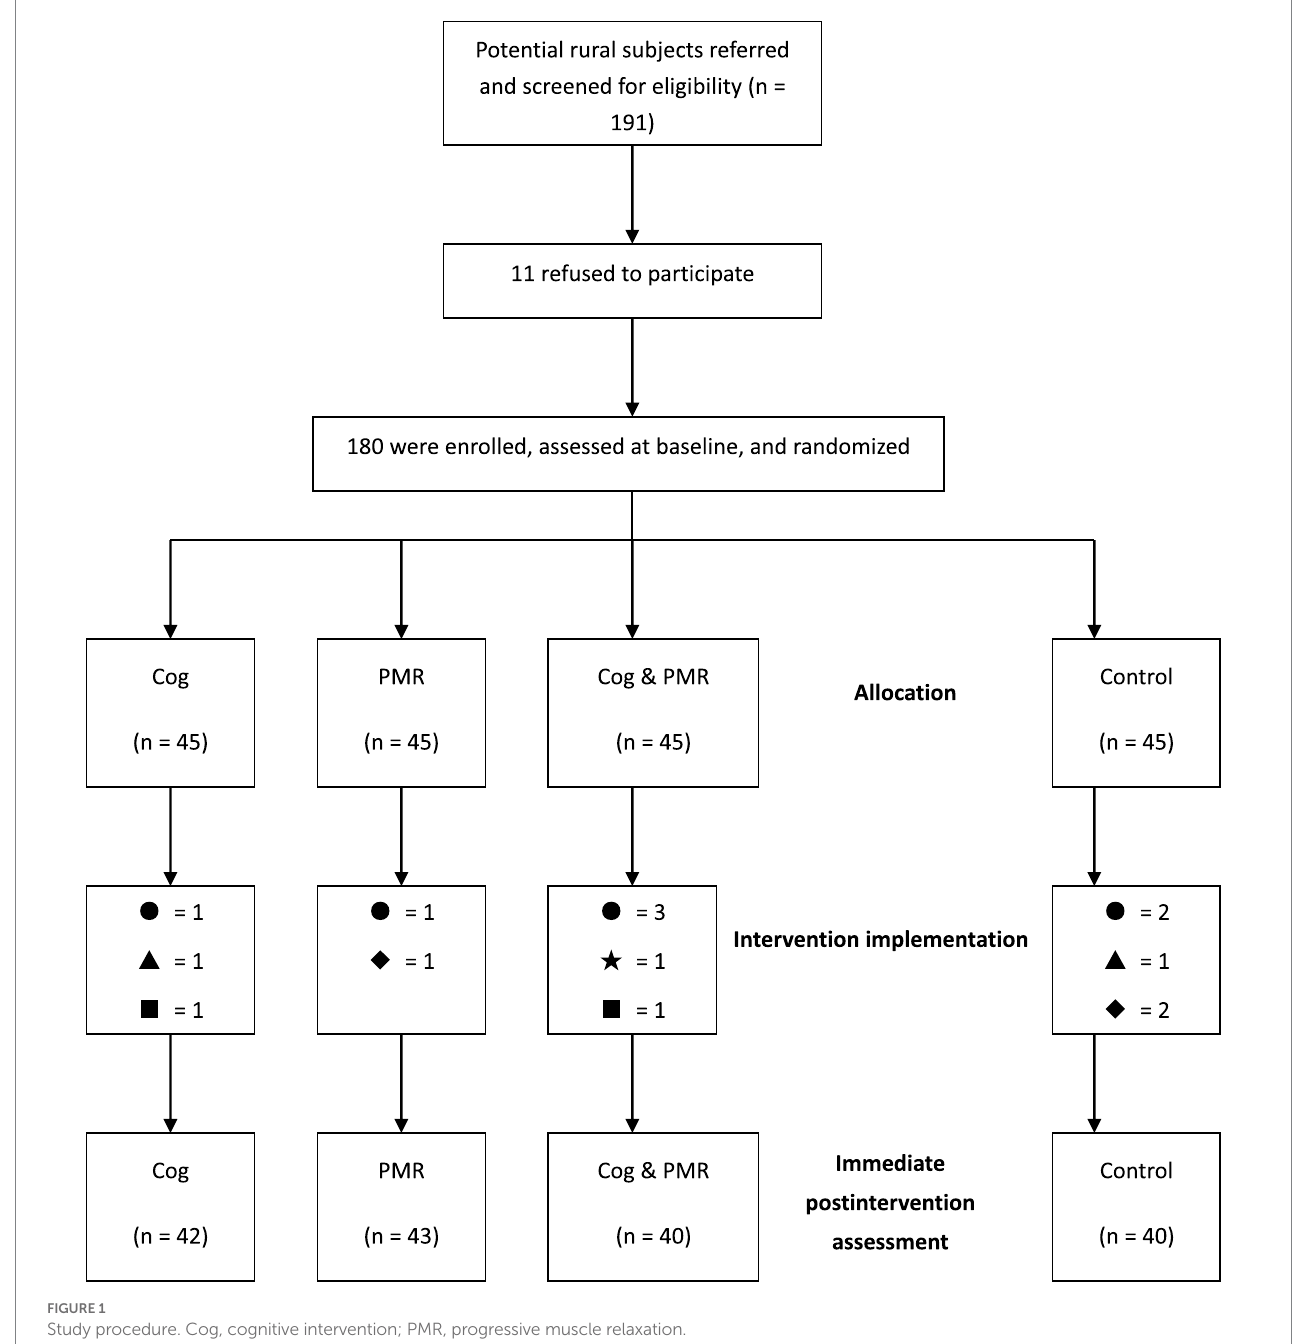
table. The three intervention groups received cognitive intervention